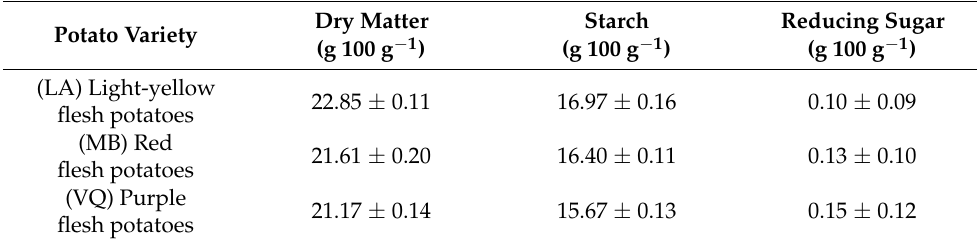
Table 3. Dry matter, starch and reducing sugars content in potato tubers (fresh weight) of varieties with light-yellow and coloured flesh (mean of